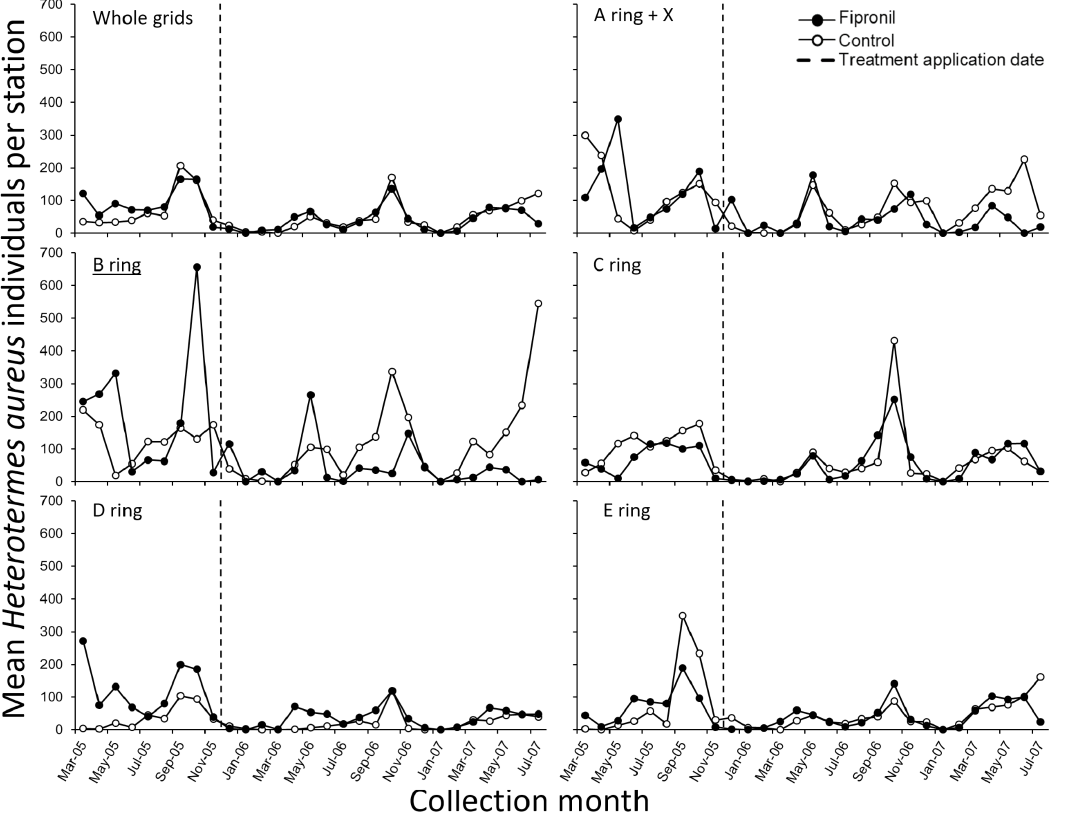
Fig 2 . Average number of desert subterranean termites collected per station per month in whole control and fipronil experimental grids and each of their sections (n= 3 for each treatment). Labels for every other collection month are included in the horizontal axes. The names of grid sections for which analysis showed a significant change in termite counts with respect to controls after treatment application are shown